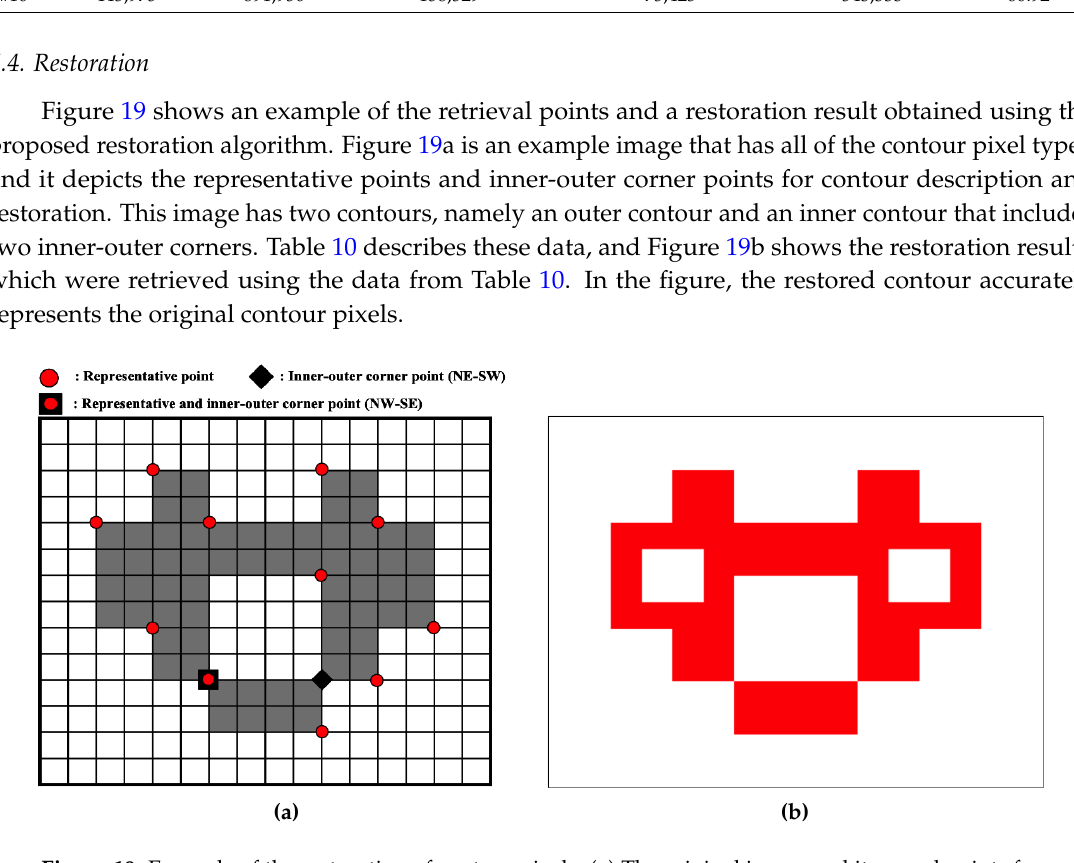
Figure 19. Example of the restoration of contour pixels. ( a ) The original image and its saved points for restoration; ( b ) restoration by the saved